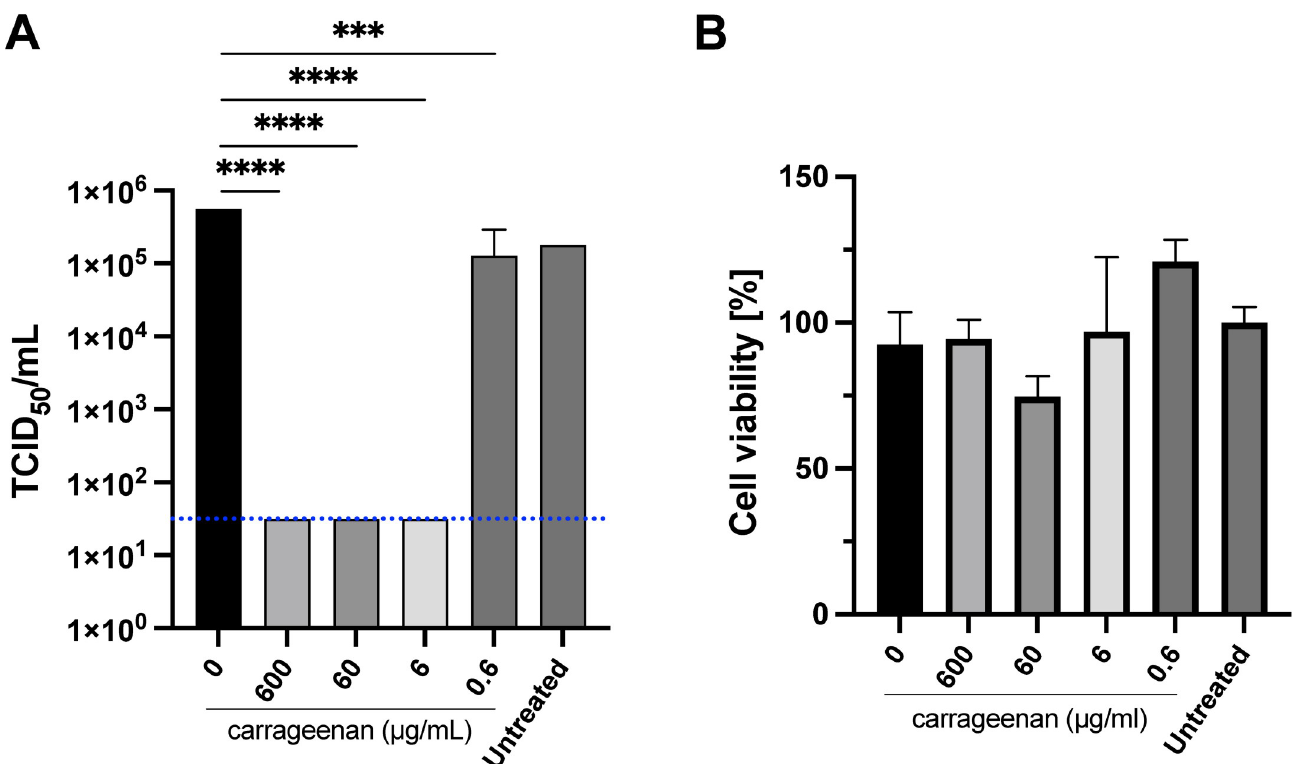
Fig 2. SARS-CoV-2 viral titer after treatment with Samples 2 and P2. A) Infection assay. Sample 2 composition: 1.2mg/mL iota-carrageenan, 5 mg/mL sodium chloride, pH 6–7. Vero E6 were pre-treated with dilutions of Sample 2 with Sample P2 (diluent without iota-carrageenan) to get 600 μ g/mL, 60 μ g/mL, 6 μ g/mL, and 0.6 μ g/mL final iota-carrageenan concentration for two hours. After this pretreatment, cells were infected with SARS-CoV-2 and incubated for 48 hours in the presence of the same dilutions of Sample 2. Supernatants were harvested and virus yield was determined using an end point dilution assay (TCID 50 ). Controls consisted of untreated infected cells or infected cells treated with P2 (no iota-carrageenan). Results were determined using the Reed and Muench formula and expressed as log TCID 50 /mL. The dotted line shows the limit of detection (LOD). Testing of samples was performed in triplicate, and the p-values are p � 0.00074 ( ��� ) and p � 0.00001. B) Cellular viability assays. Vero-E6 cells were treated with iota-carrageenan or vehicle (600 μ g/mL to 0 μ g/mL) for 48 h at 37˚C. After incubation, cellular viability was analyzed, and no statistically significant difference was found between the groups compared to the untreated control group (Group 600 μ g/ml, p = 0.9880, Group 60 μ g/ml, p = 0.0683, Group 6 μ g/ml, p = 0.9993, and Group 0.6 μ g/ml, p = 0.1957). Data are expressed as mean ± SD.